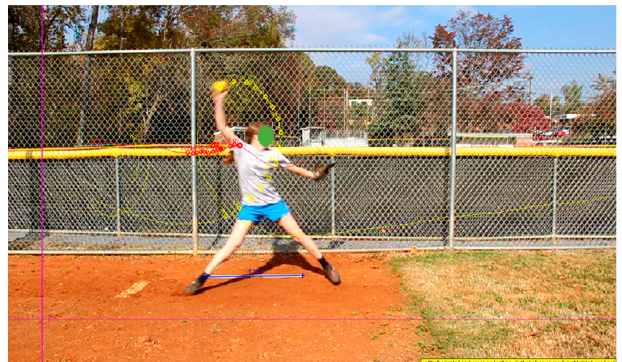
Figure 2. Softball player in the act of pitching. Both the softball and the pitcher’s right shoulder were tracked.